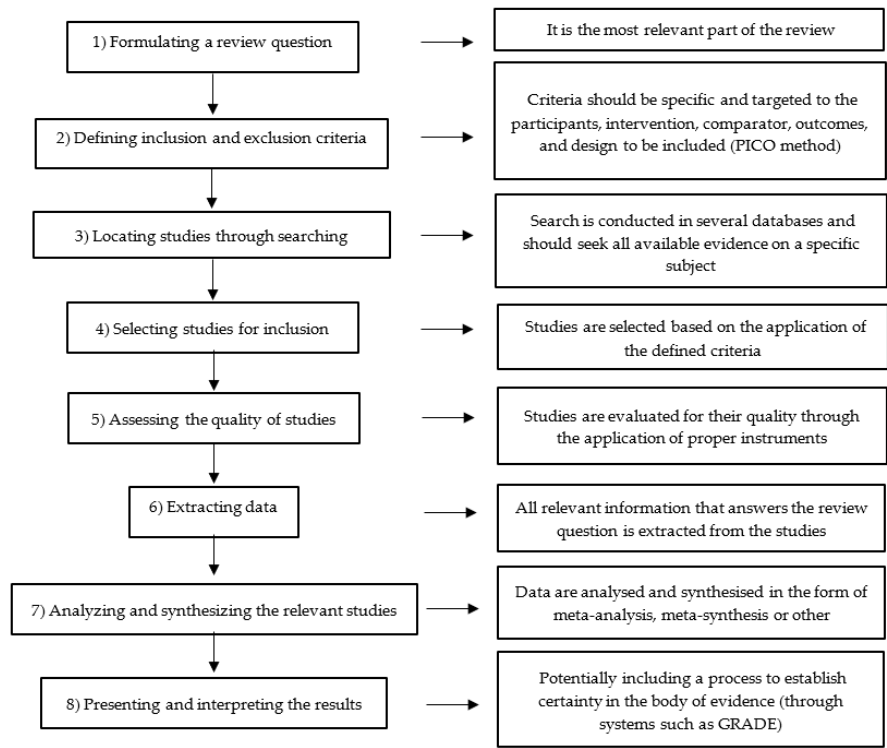
Figure 1. The JBI method and its procedures.